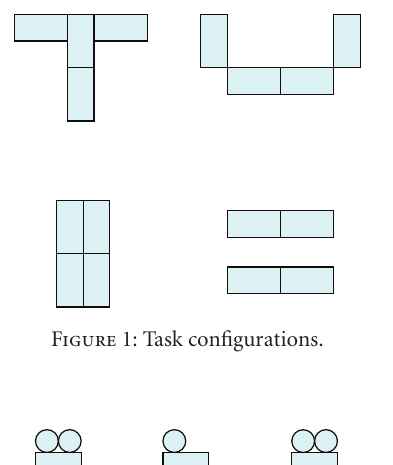
Figure 1: Task configurations.